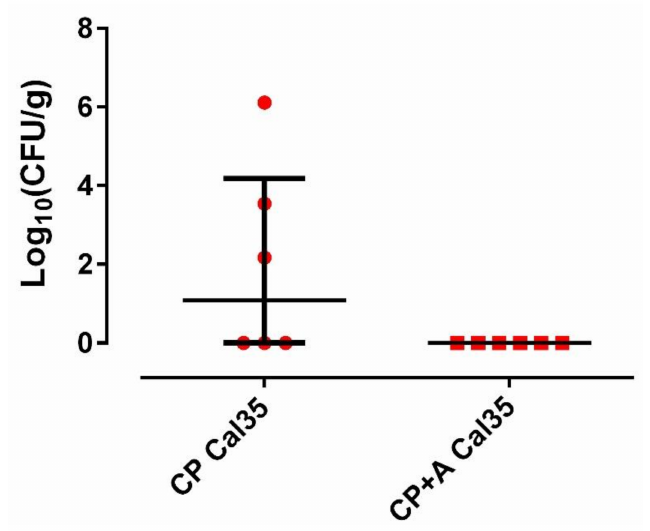
Figure 5. Quantity of yeast per gram of femur from each group of